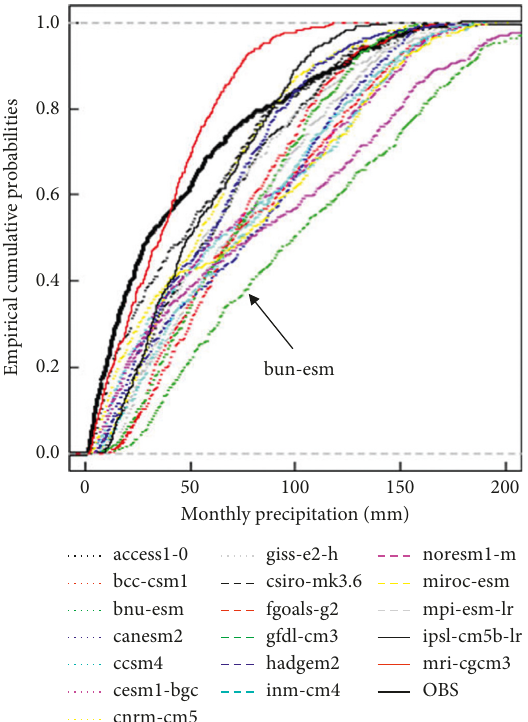
Figure 7: Empirical cumulative probabilities of monthly mean precipitation from observations and GCMs.